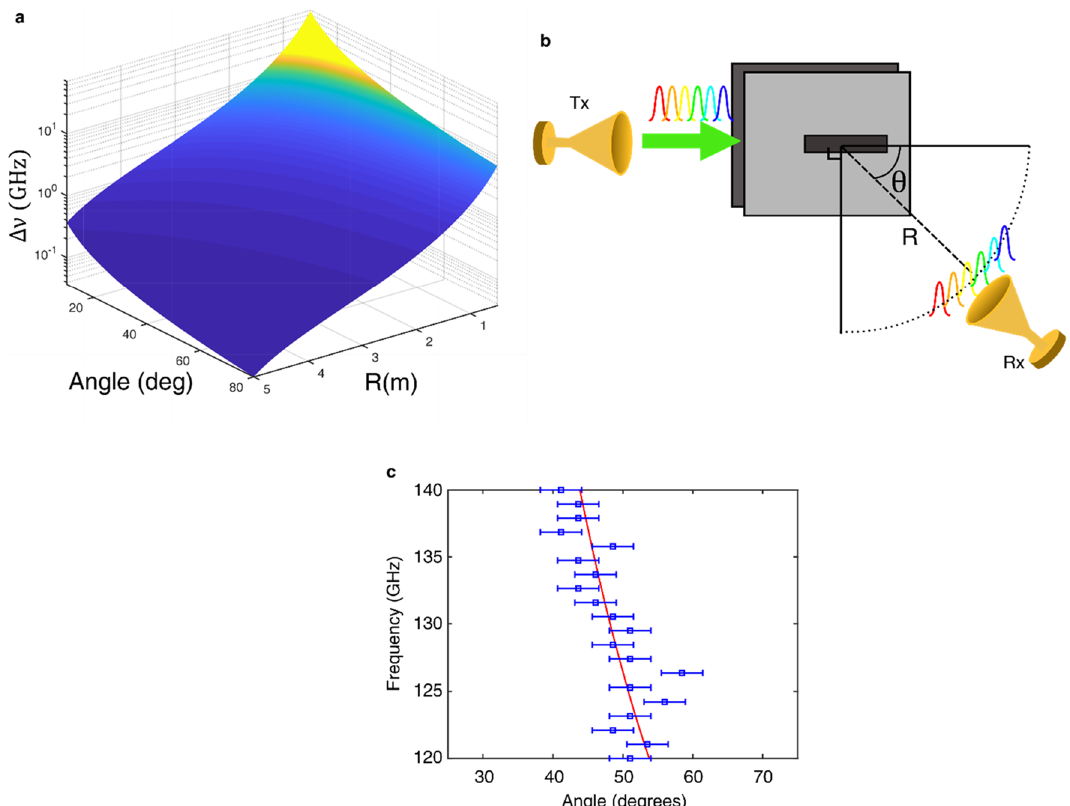
Figure 3. ( a ) The calculated spectral bandwidth, �ν , of the system decreases nonlinearly as the angle and distance is increased. ( b ) Experimental setup for measuring the radiated frequency components from the leaky wave antenna. The LWA transmits 20 tones from 120 to 140 GHz (1 GHz separation) and the signal power is detected at a receiver with a radial distance of R and angle θ . ( c ) The angular location of the peak detected power of each tone between 25° and 75°, at a distance of 200 cm. The maximum power of each tone shifts from 45 to 53 degrees. The error bars indicate the 3-degree uncertainty in angular position. This shift in peak matches the analytical calculations from Eq. (4) (red